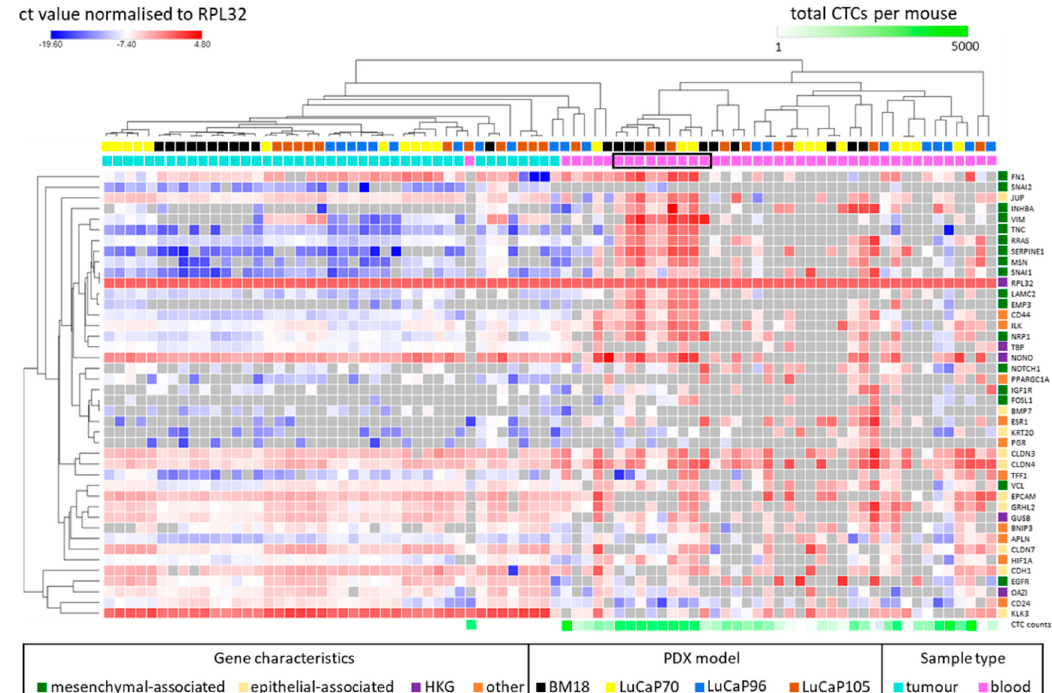
Figure 5. Heat map showing 42 gene panel expression profiles in blood and matched tumour samples as Ct values normalised to RPL32 , with global normalisation. Hierarchical unsupervised clustering was performed using one minus Pearson correlation. For each sample, the PDX model is shown above the heat map, followed by colour coding to indicate tumour (teal) and blood (pink) biospecimens. The final row indicates estimated circulating tumour cell (CTC) counts for each blood sample. Black block indicates cluster of blood samples showing evidence of a hybrid phenotype. Genes are categorised as mesenchymal-associated, epithelial-associated, potential HKG ( GUSB , TBP , OAZ1 and NONO ), and others (which includes HR- ( ESR1 , PGR and TFF1 ), CSC- ( CD24 and CD44 ), hypoxia- ( APLN , HIF1A and BNIP3 ), metabolism- ( PPARGCIA ), and anoikis- ( ILK ) associated genes). HR, hormone receptor; CSC, cancer stem cell; HKG, housekeeper gene.